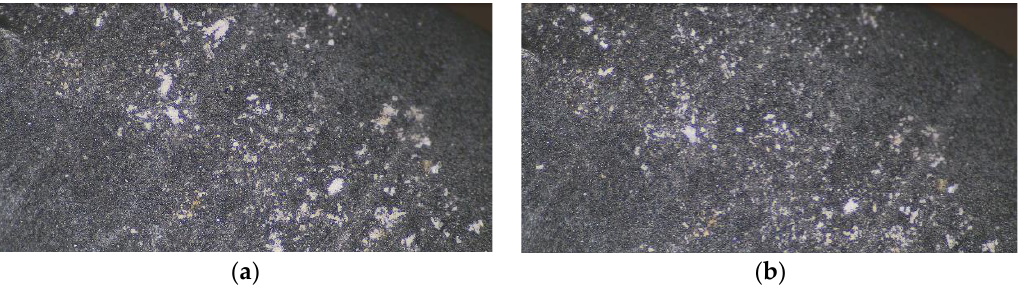
Figure 12. Comparison of dust particles on the vibrator surface: ( a ) Before vibration; ( b ) After vi- bration.